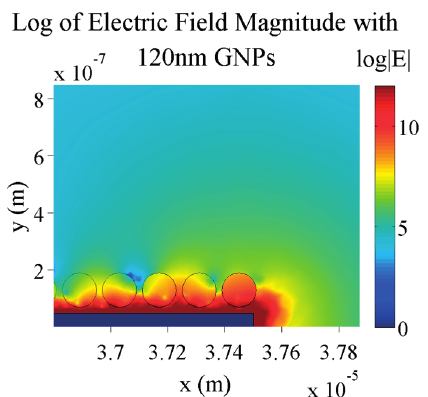
Figure 13. Simulation of the electric field magnitude of 5 µm digit and 2.5 µm gap electrodes with 0.1 V applied, 10 mM KCl concentration and 120 nm GNPs bound to the